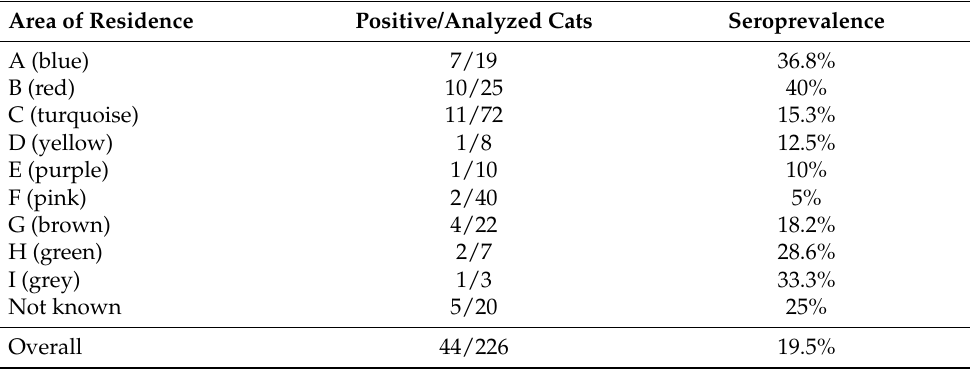
Table 2. Seroprevalence of animals according to the residence